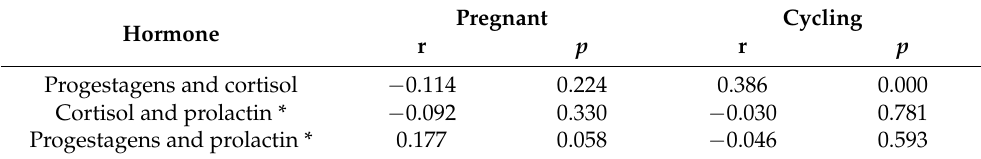
Table 4. Correlations between hormone concentrations in pregnant and cycling elephants. Pregnant Cycling Hormone r p r p Progestagens and cortisol − 0.114 0.224 0.386 0.000 Cortisol and prolactin * − 0.092 0.330 − 0.030 0.781 Progestagens and prolactin * 0.177 − 0.046